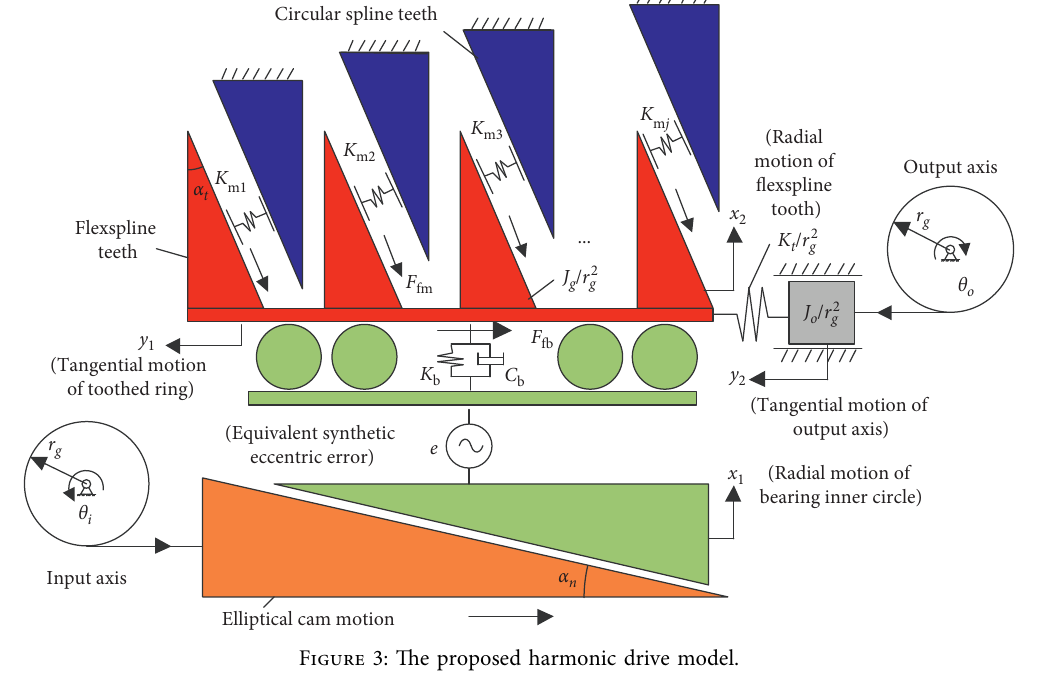
Figure 3: The proposed harmonic drive